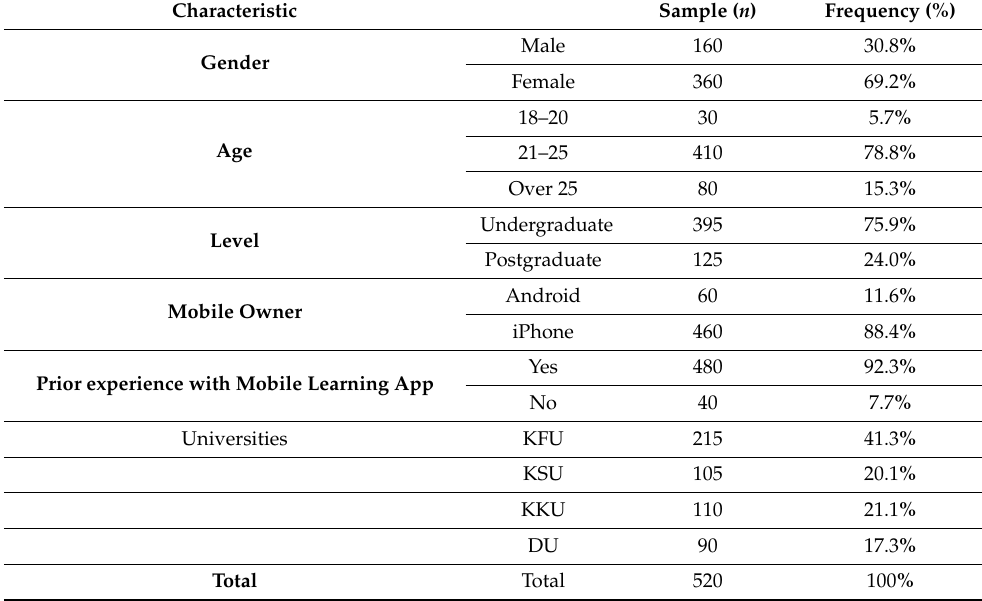
Table 1. Analysis of Demographic